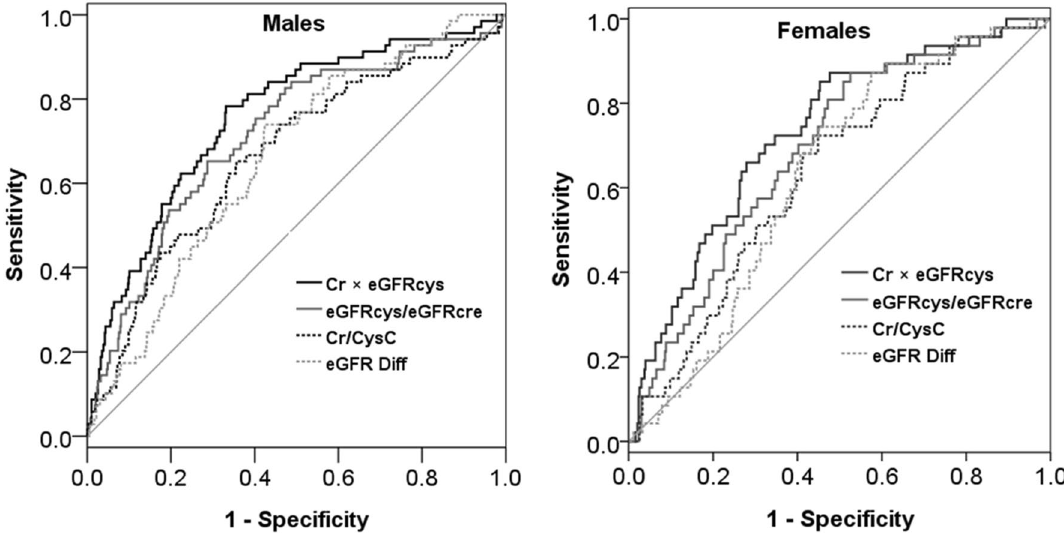
Figure 1. Receiver operating characteristic curves of sarcopenia indices on the prediction of mortality in male and female CKD patients. AUC (95%